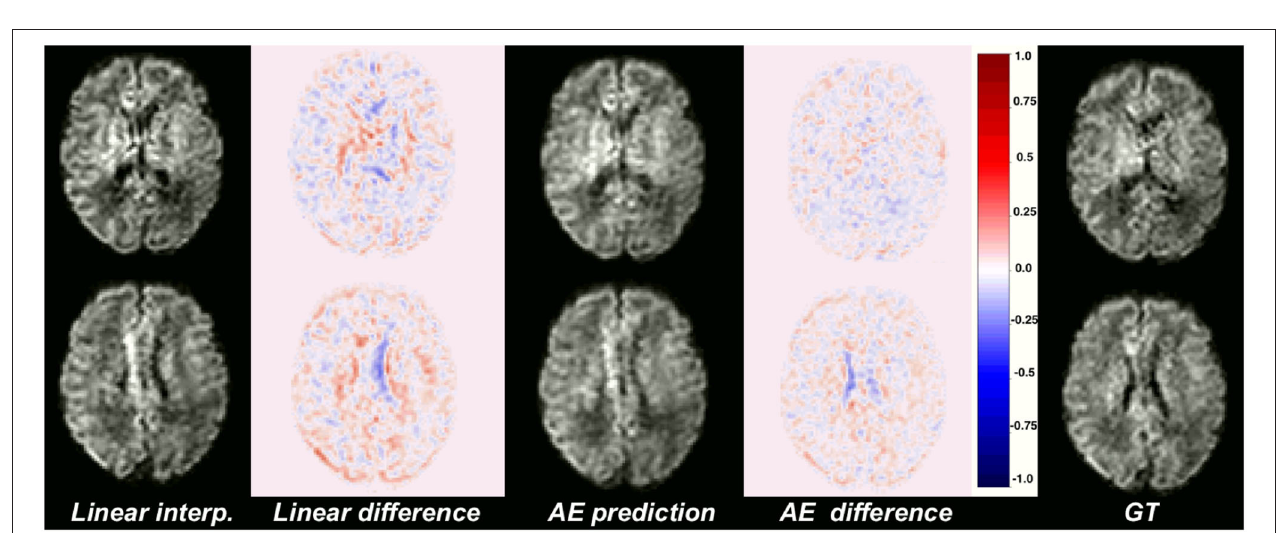
FIGURE 4 | Illustration of the error difference in b1000 with respect to the ground truth (GT) for the best baseline method (trilinear, left) and autoencoder (AE, middle) enhancement.